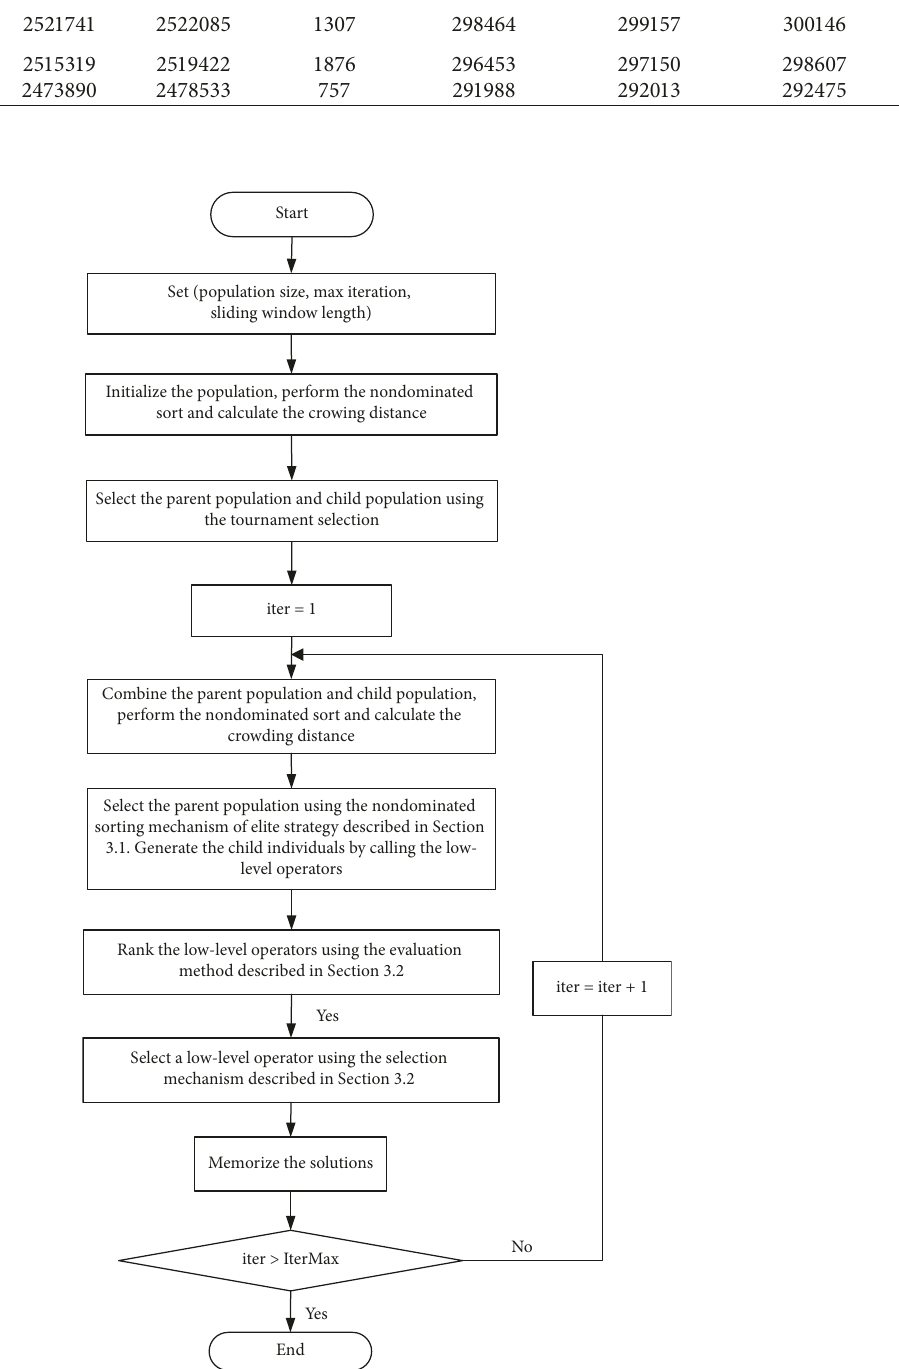
Figure 2: Flowchart of the proposed SHHA for DEED.